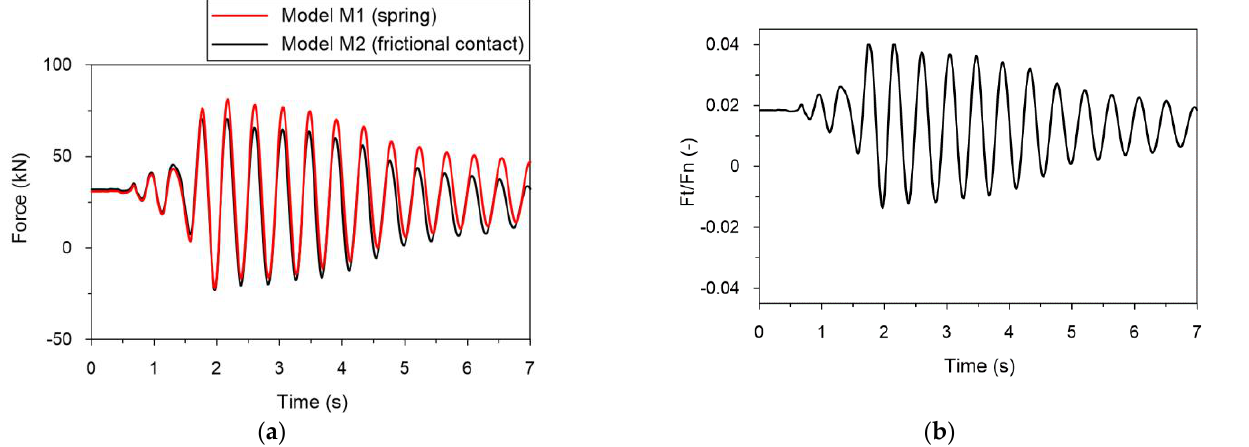
Figure 19. Comparison of: ( a ) horizontal forces generated in the connector (models M1 and M2); ( b ) friction force to normal contact force ratio (model M2), obtained for the low-intensity tremor (D_0).